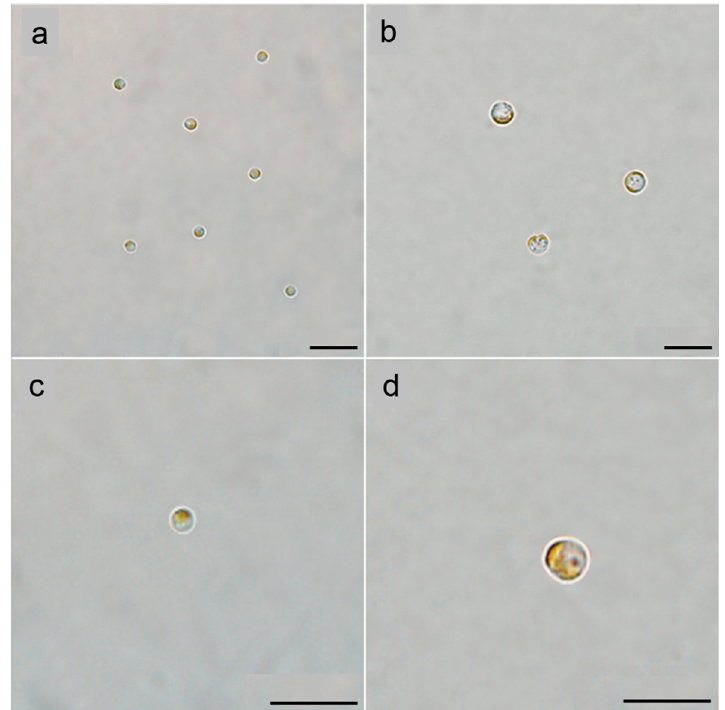
Figure 1. Light microscopic observations of the resting stage cells (RSCs) and normal vegetative cells (VCs) of A. anophagefferens strain CCMP1984. ( a , c ) VCs at magnifications of 400 ( a ) and 1000 ( c ); ( b , d ) RSCs at magnifications of 400 ( b ) and 1000 ( d ). Scale bars = 10 µ m.